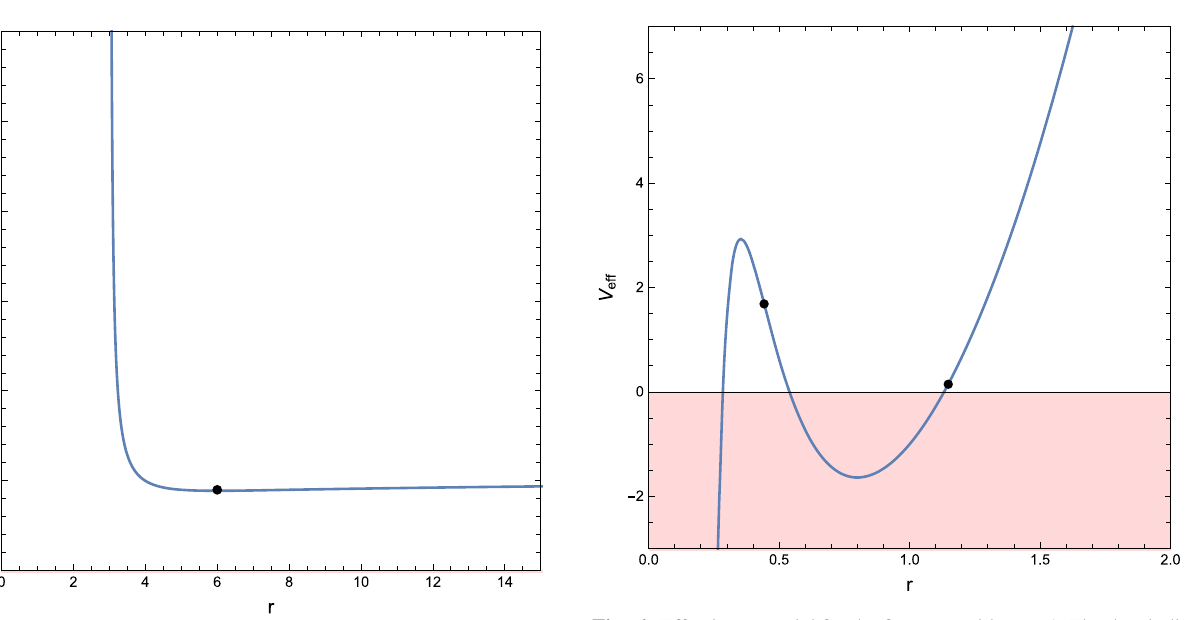
Fig. 5 Effective potential for the Schwarzschild black hole in the case of m g = 0.Thedotindicatesthelocationoftheinnermoststablecircular orbit, r ISCO = 6 Table 1 Location of the event horizon and the innermost stable circular orbit for the case of ( m g = 0) which recovers Schwarzschild black hole m g Event horizon Innermost stable circular orbit 0 2 6